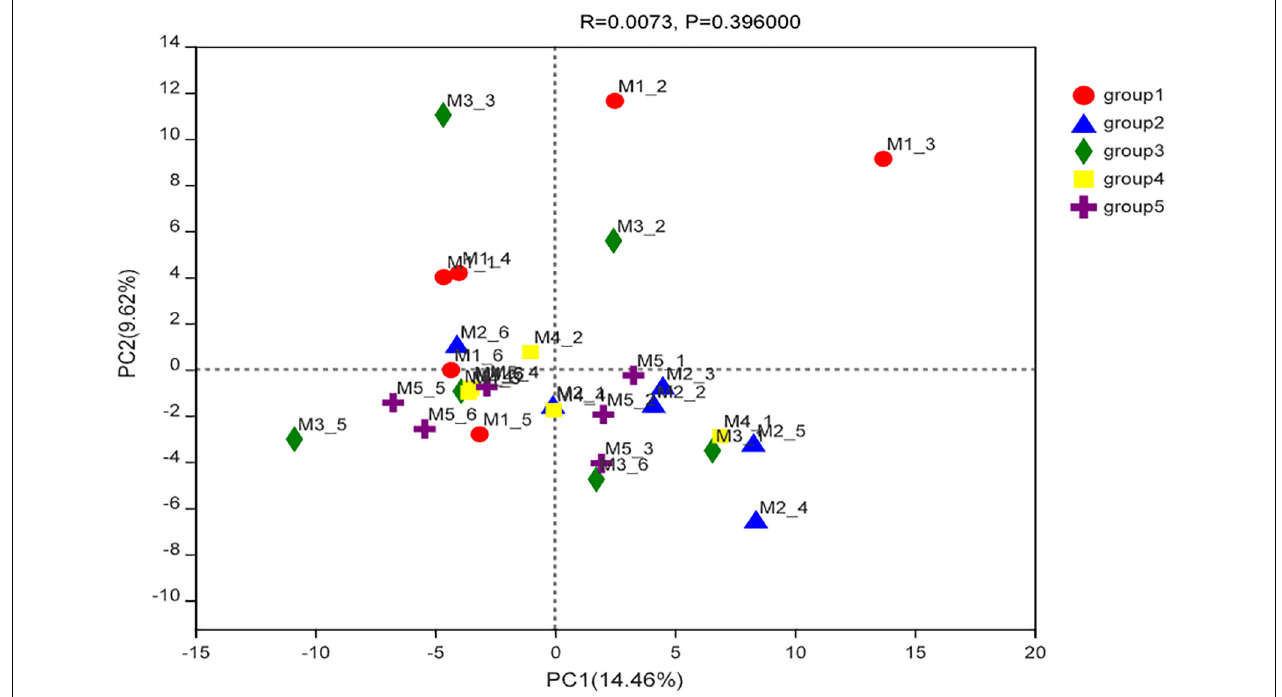
FIGURE 2 | Principal component analysis ordinated plots of cecal microbial composition at the genera level of ducks in different groups.